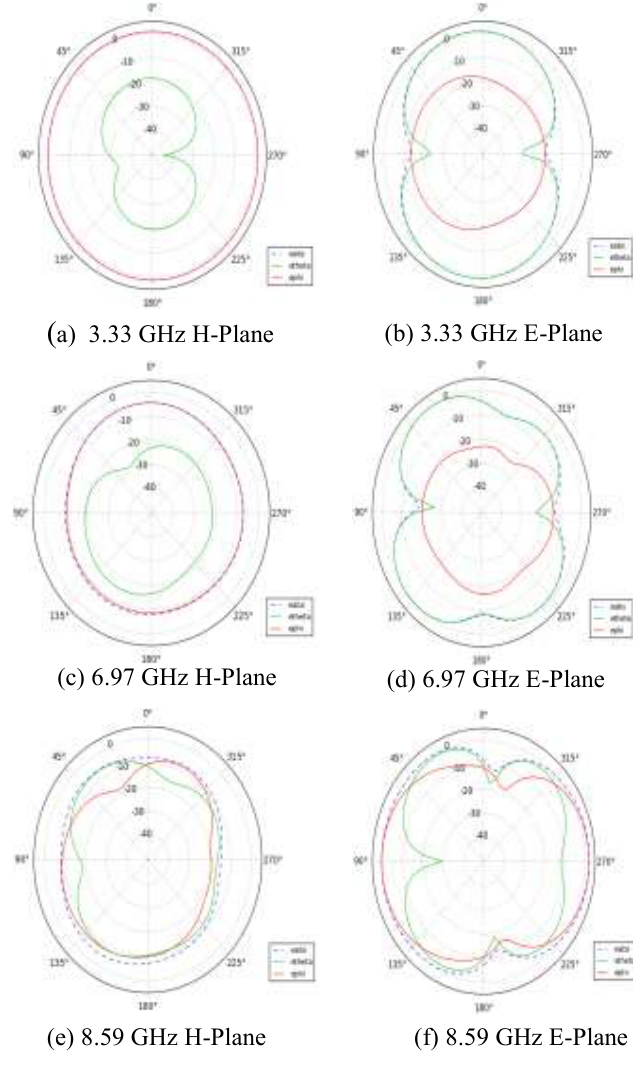
Figure 12: Simulated radiation pattern of the proposed antenna at three resonant frequencies